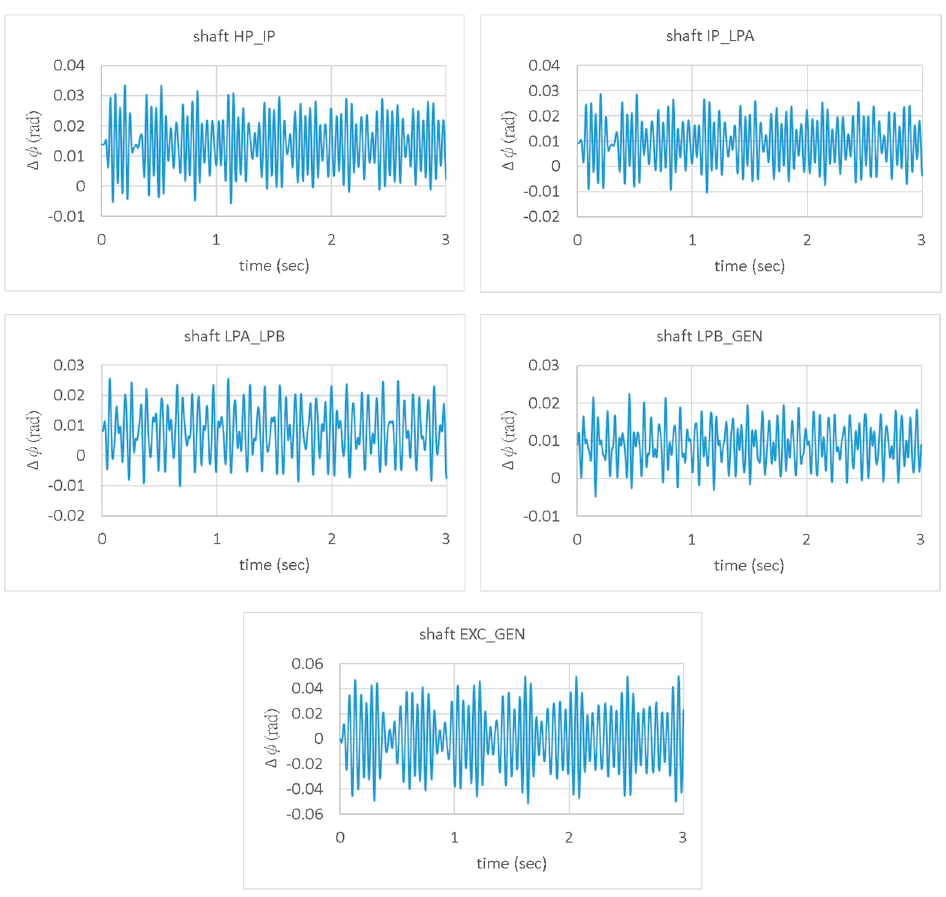
Figure 18. Turbine shaft transient responses with MOV for DFIG wind farm integration.